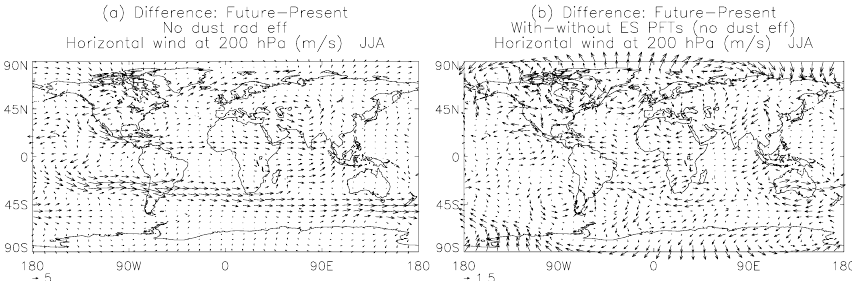
Fig. 17. Horizontal wind at 200hPa (ms − 1 ): (a) future-present changes for HadGEM2-A; (b) the impact of the ES land cover on the future-present differences (with no dust radiative effects). Note different